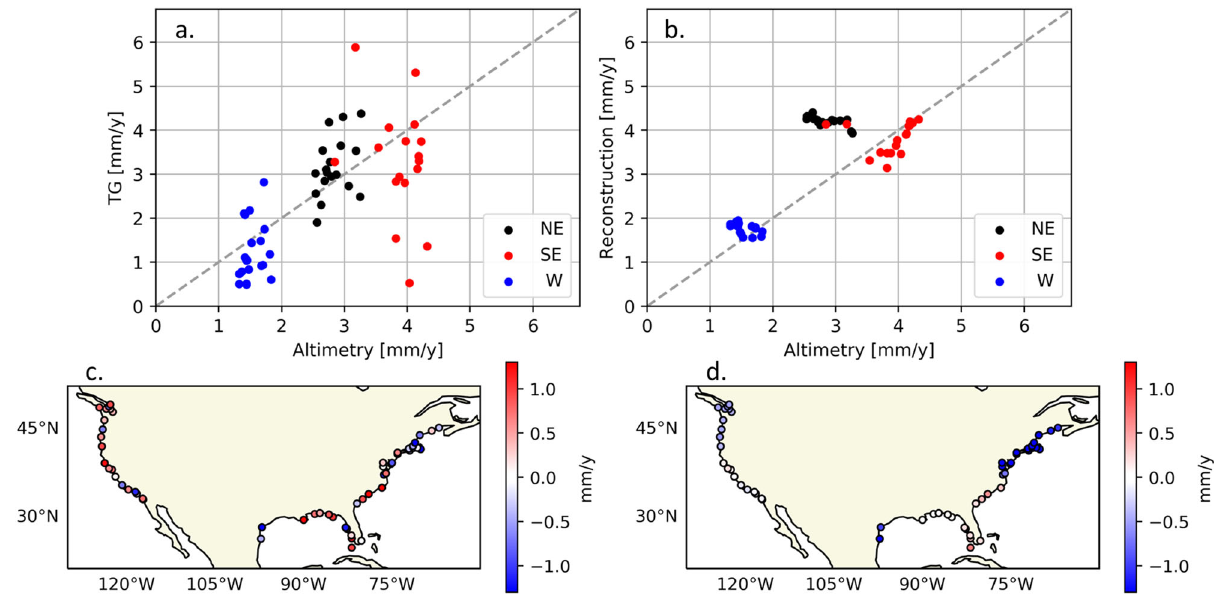
Fig. 8 Assessment of the trends observed by altimetry. a , c Comparison with tide-gauge observations (VLM removed). b , d Comparison with the sum of sterodynamic effects and contemporary mass redistribution and non-VLM GIA.